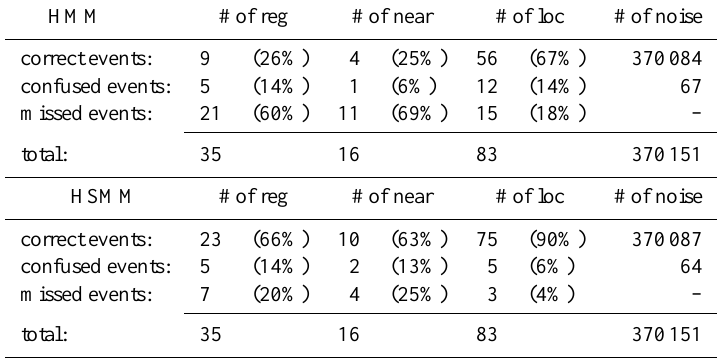
Fig. 9. The top plot shows three local earthquakes. The second and third plot shows the resulting log probabilities from HMM and HSMM detection and classification respectively. Colored bars denote the log probability of the earthquake classes, while the dashed lines denote the corresponding noise classes for each earthquake class. Table 2. Results of one month of continuous classification. Confused events are events which are misclassified to another earthquake class. The confused events for the noise class correspond to the false alarms. For the comparison, the post-processing thresholds for both HSMM and HMM are chosen such that the false alarm rate stays for both algorithms at about two false alarms per